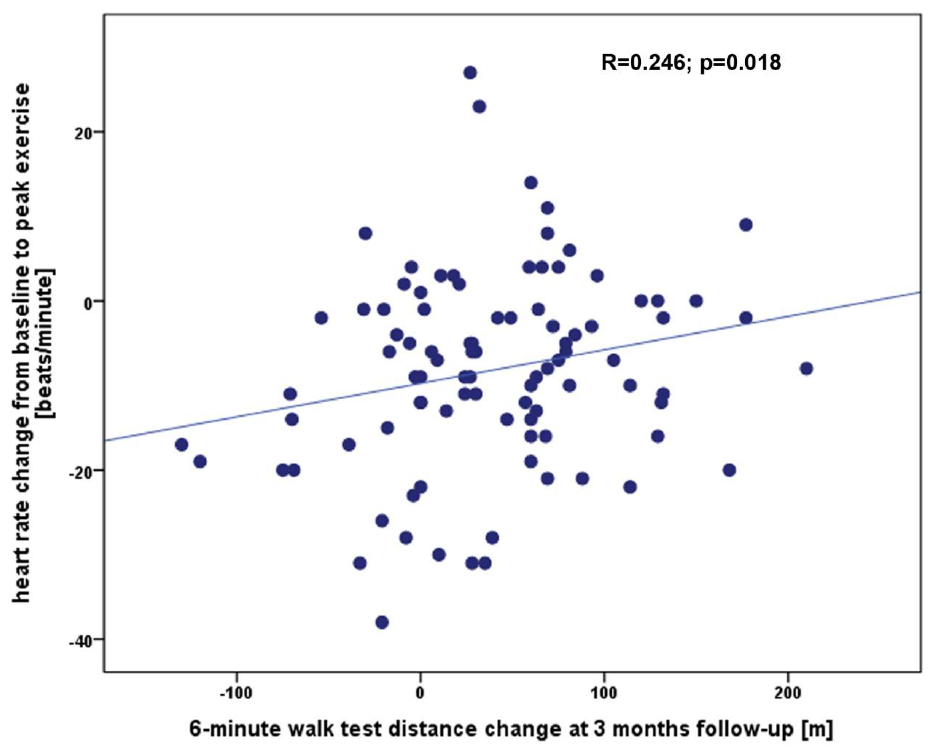
Figure 2. The correlation between the Δ6MWTD at the 3 -month follow-up and the difference in heart rate between baseline and peak exercise.